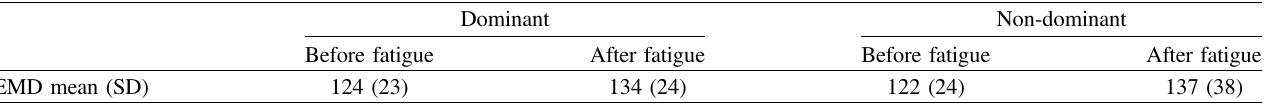
Table 1. Electromechanical delay (EMD) in msec for leg laterality and